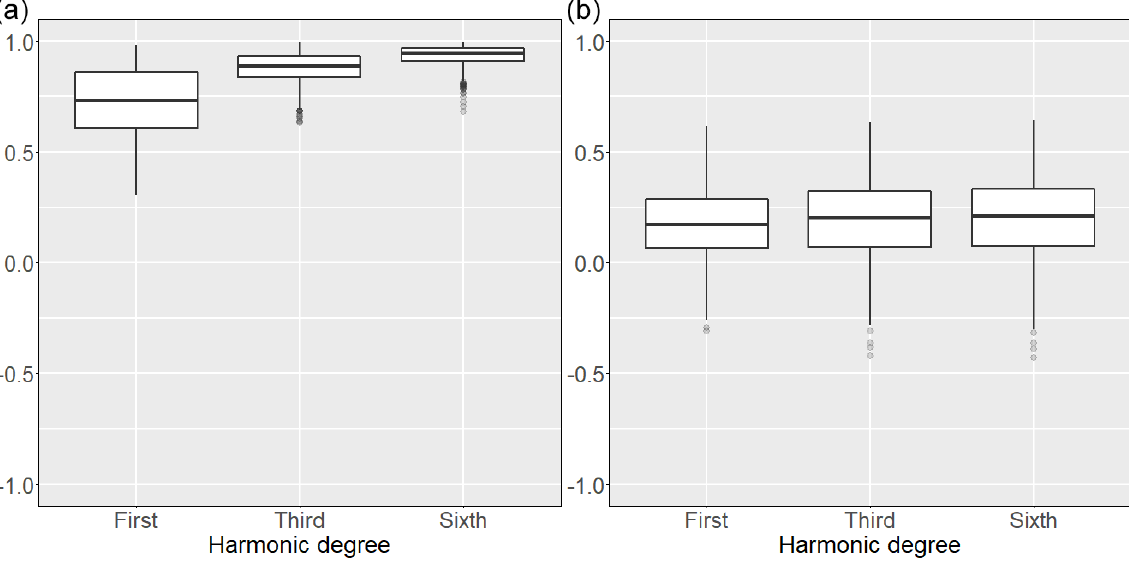
Figure 4. Boxplots of correlation scores between monthly MODIS NDVI ∆ Harmonic values and MODIS NDVI z-score ( a ) as well as scPDSI ( b ) values. A higher harmonic degree leads to overall higher correlation scores. scPDSI vs. ∆ Harmonic r values ( b ) are significantly lower compared to z-score vs. ∆ Harmonic r values ( a